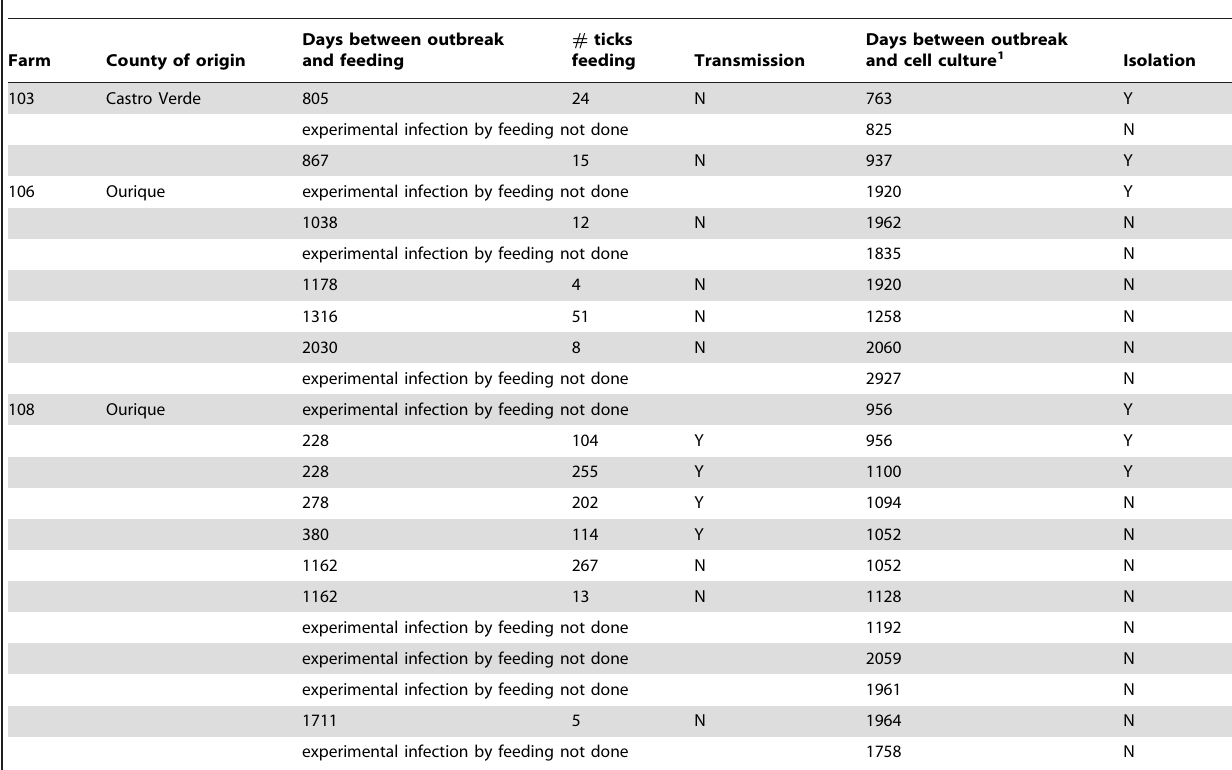
Table 1. Results of experimental feeding and cell